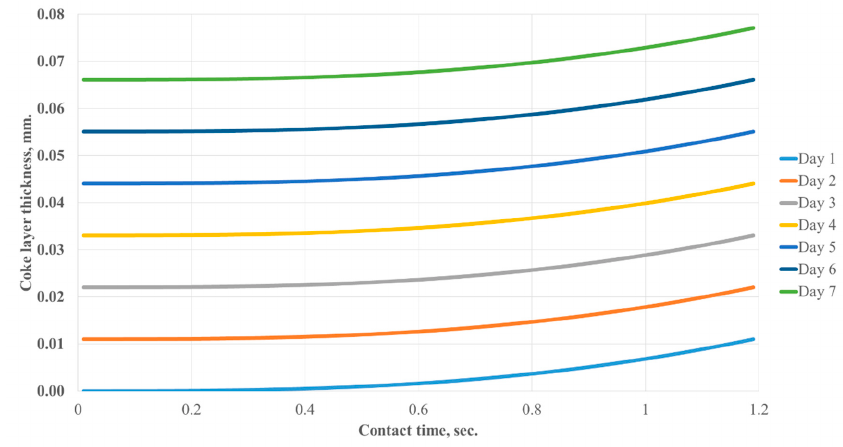
Figure 4. Change of the coke layer thickness.